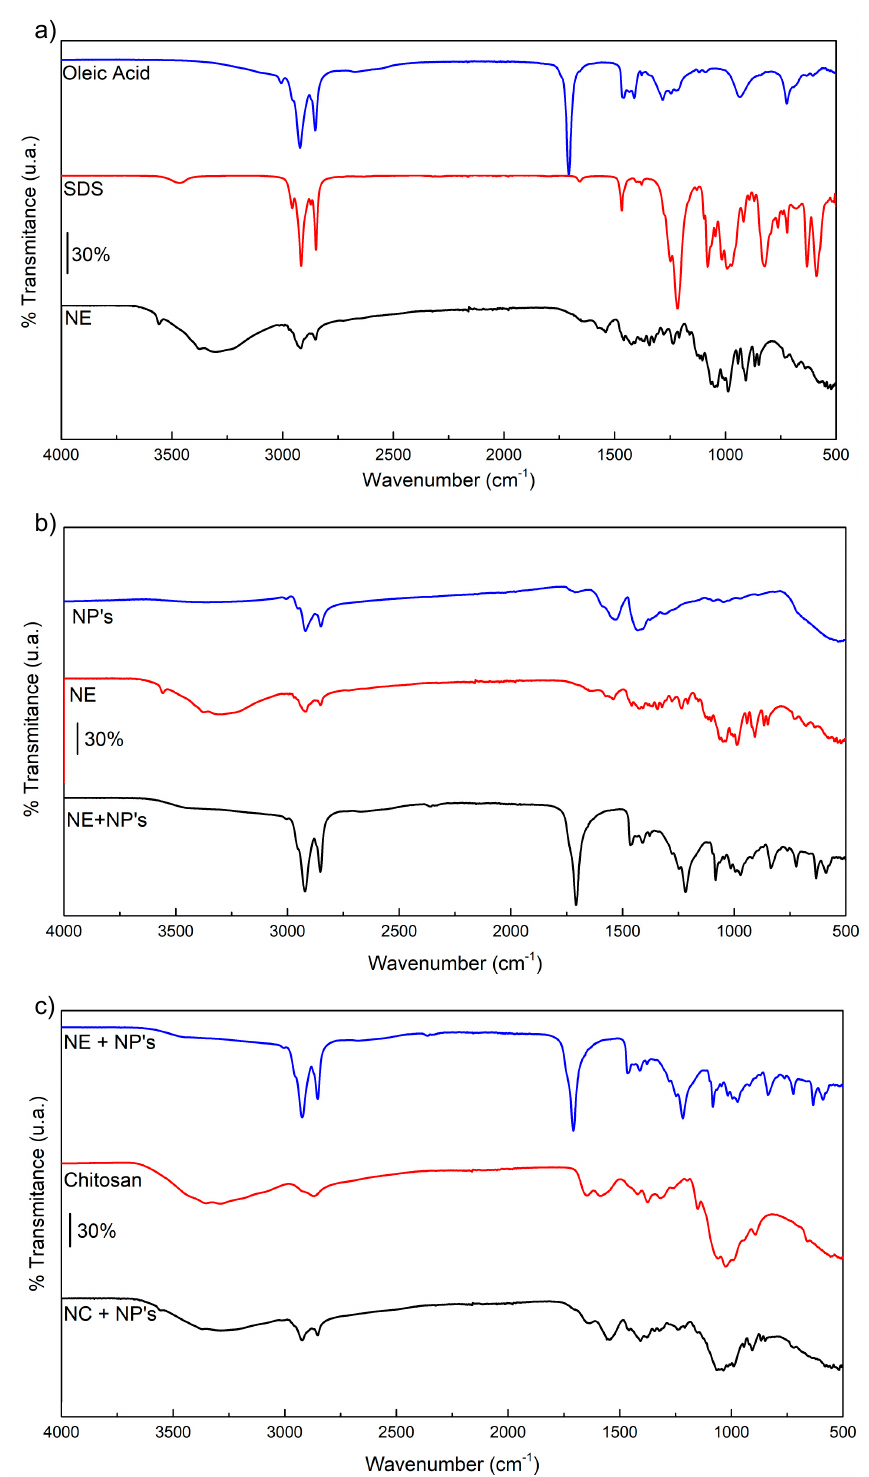
Figure 4. FTIR spectra of the ( a ) nanoemulsion (NE) and its precursors: oleic acid and sodium dodecyl sulfate (SDS). ( b ) Nanoemulsion with and without iron carbide@iron oxide nanoparticles (NP´s). ( c ) Nanocapsules (NC) and their precursors: chitosan and nanoparticles. The bars indicate 30% intensity of transmittance.